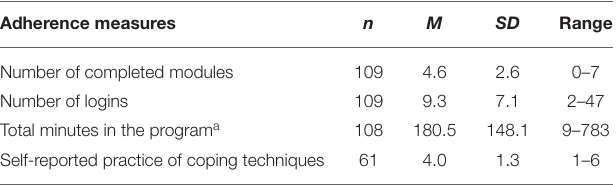
TABLE 2 | Descriptives of adherence measures. Adherence measures